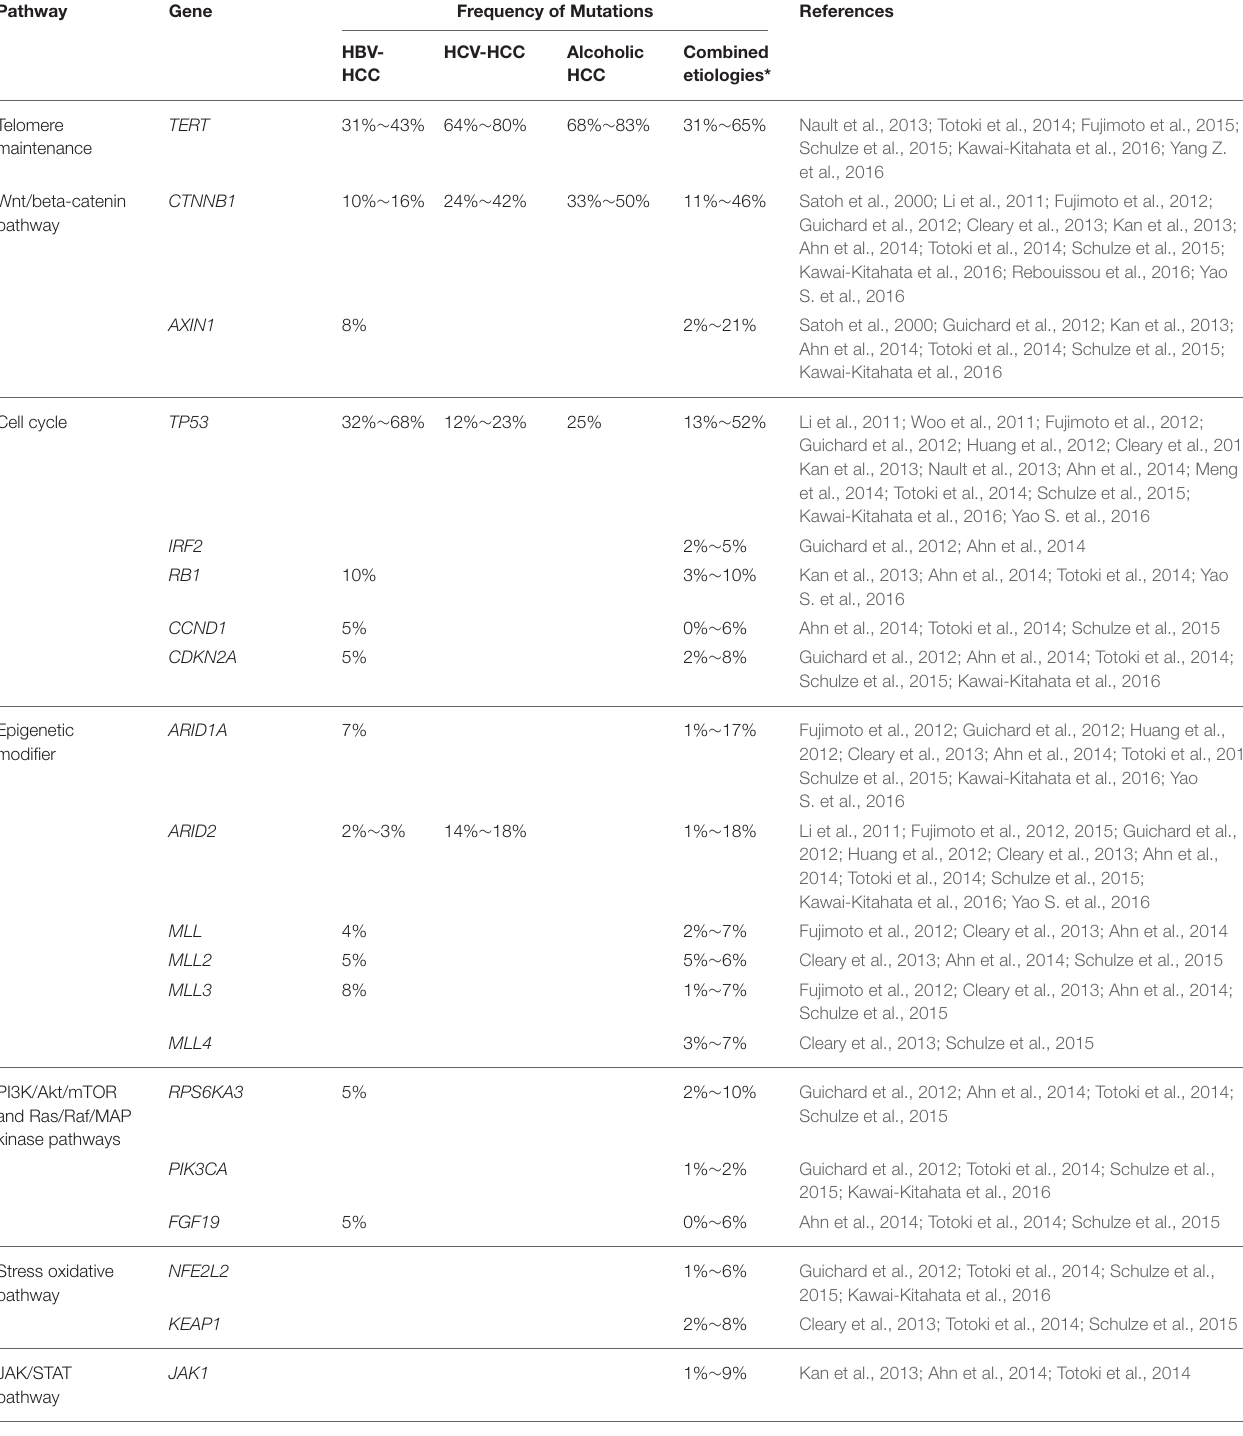
TABLE 4 | Recurrent somatic mutations in HCC tissues.